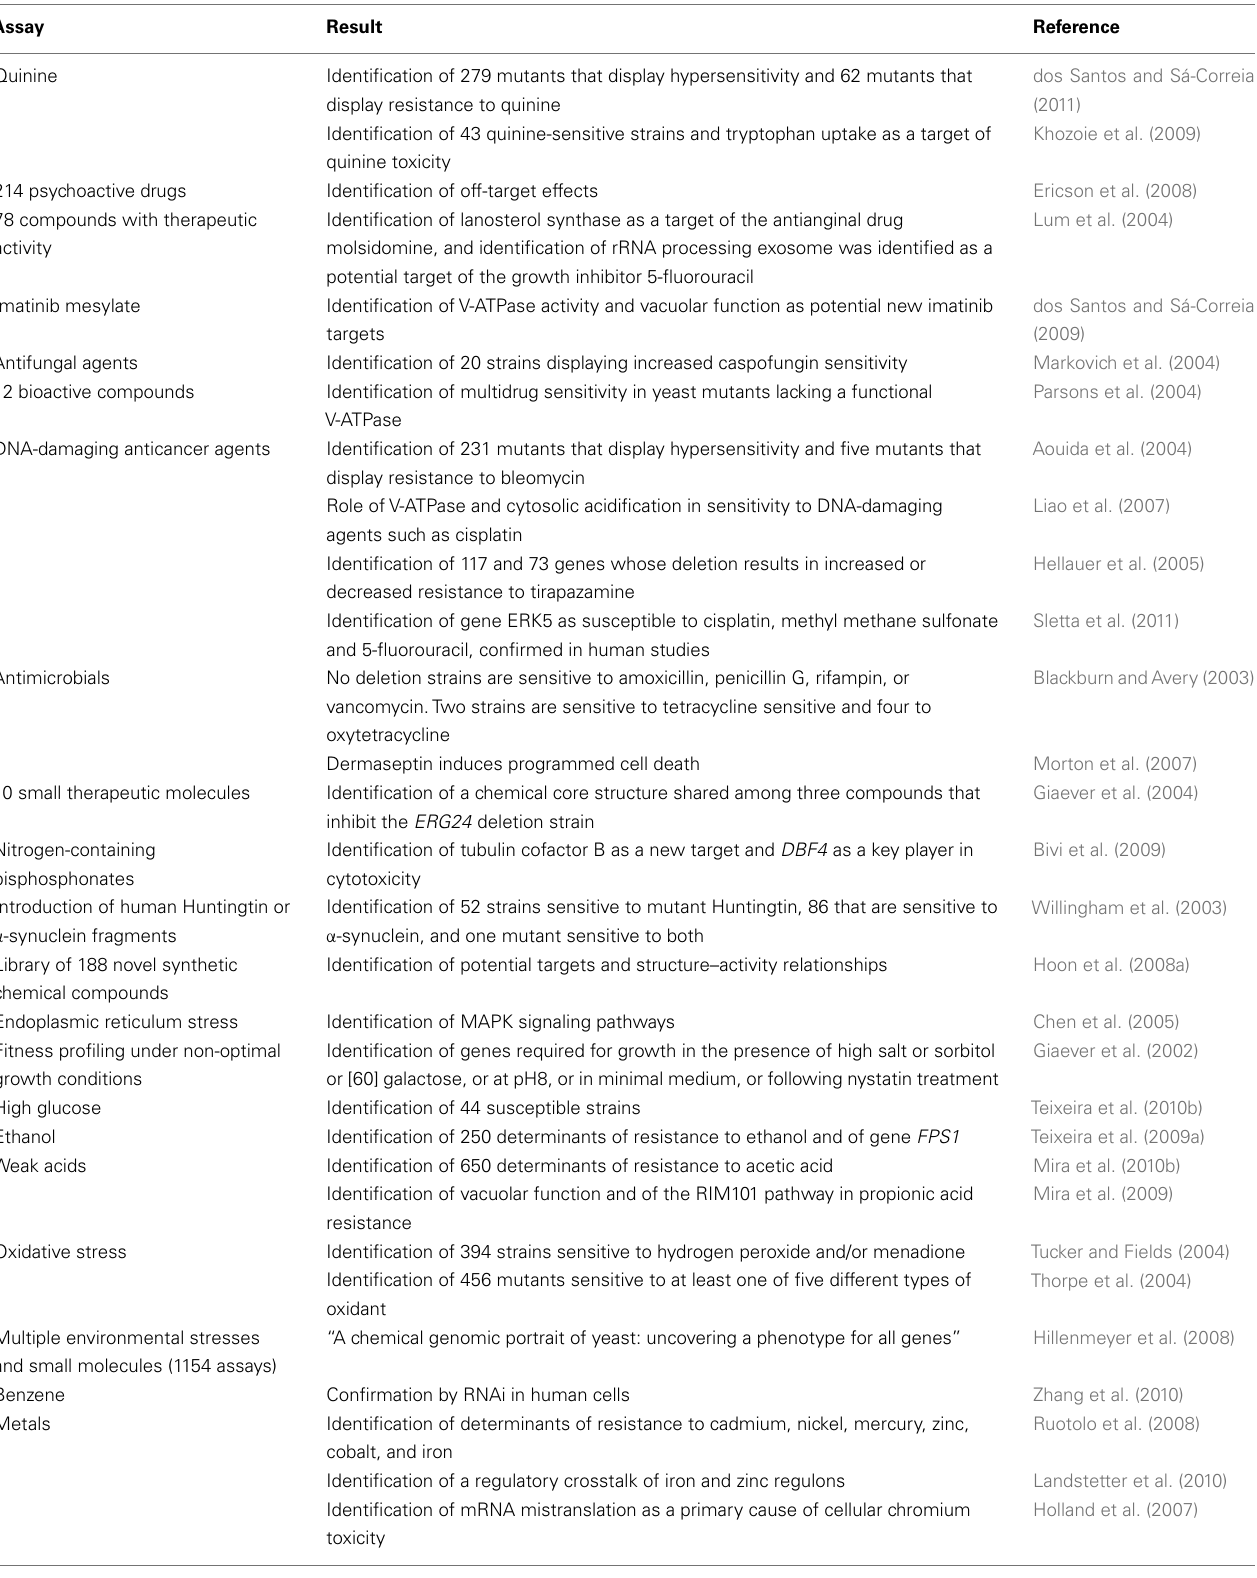
Table 1 | Selected publications in yeast toxicogenomics studies using deletion mutant